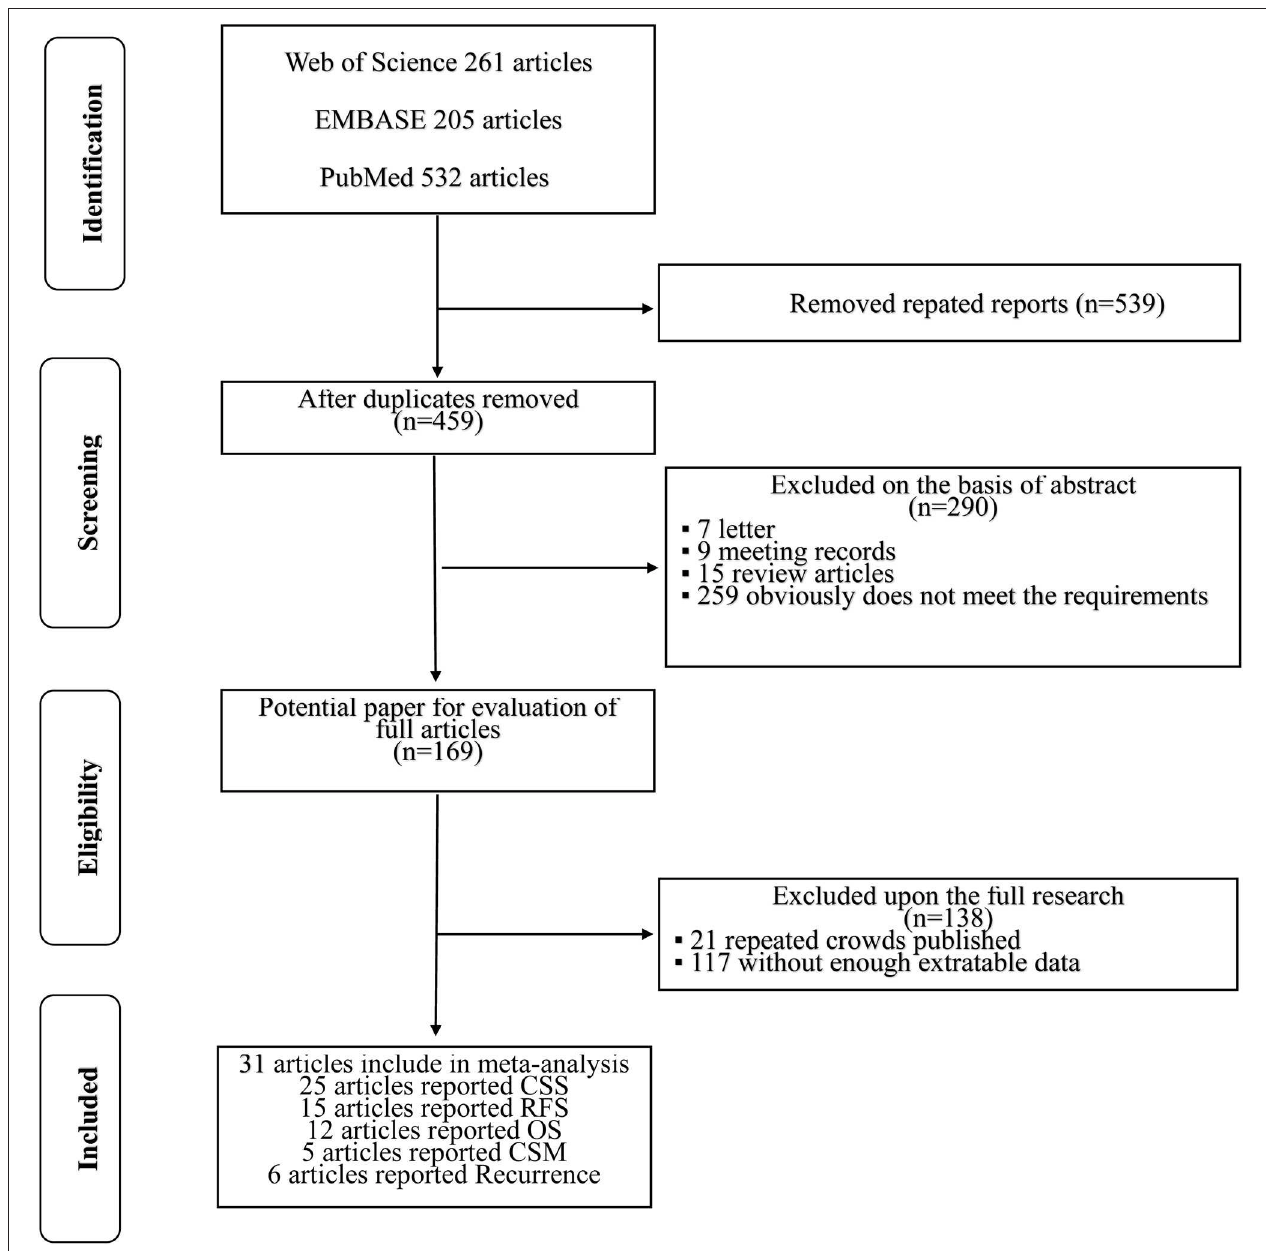
FIGURE 1 | PRISMA flow chart of literature search and selection process.